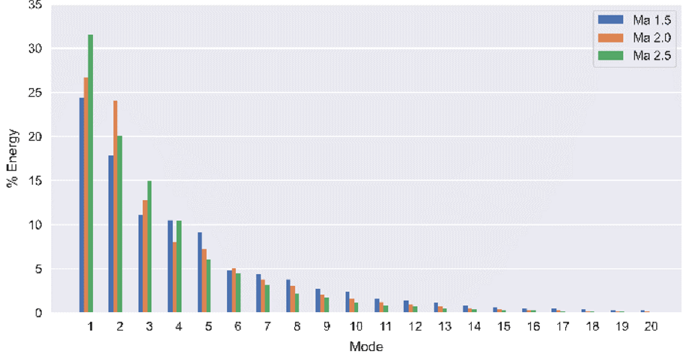
Figure 13. The energy percentage of the first 20 modes in the SWBLI region in three different Mach numbers.